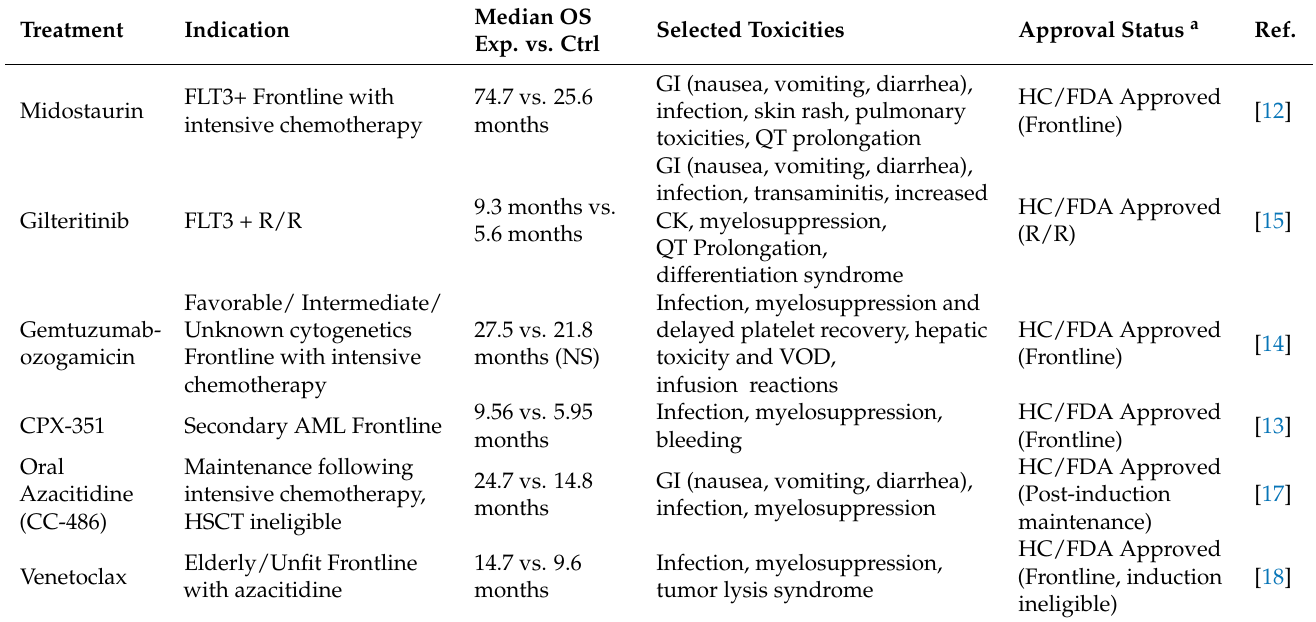
Figure 1. Overview of frontline intensive treatment of AML. Table 2. Overview of Newer Drug Approvals in AML [12–18].